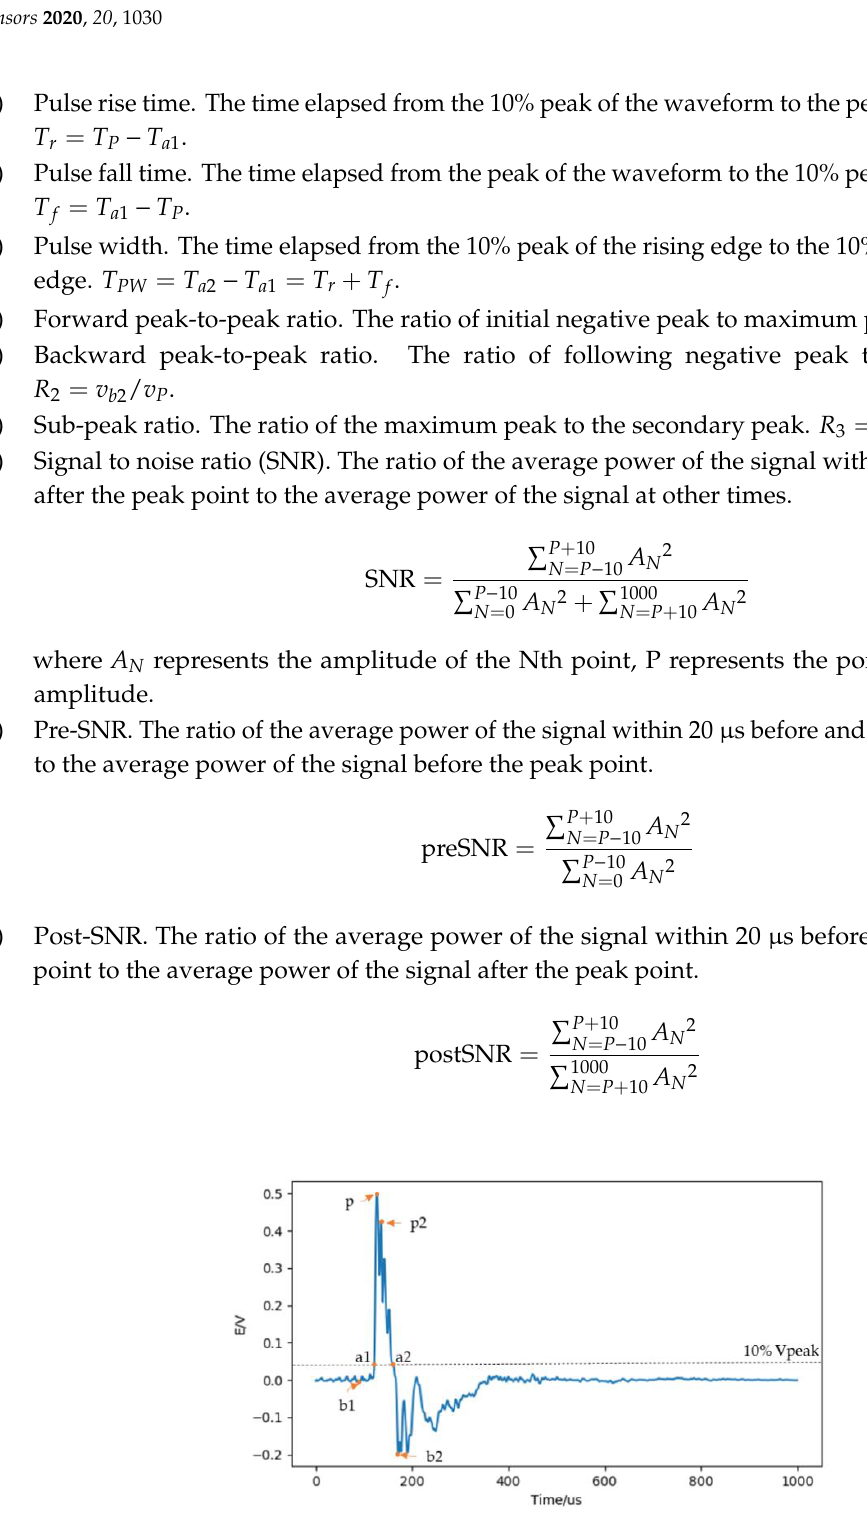
Figure 9. Schematic diagram of waveform characteristic parameter definition.